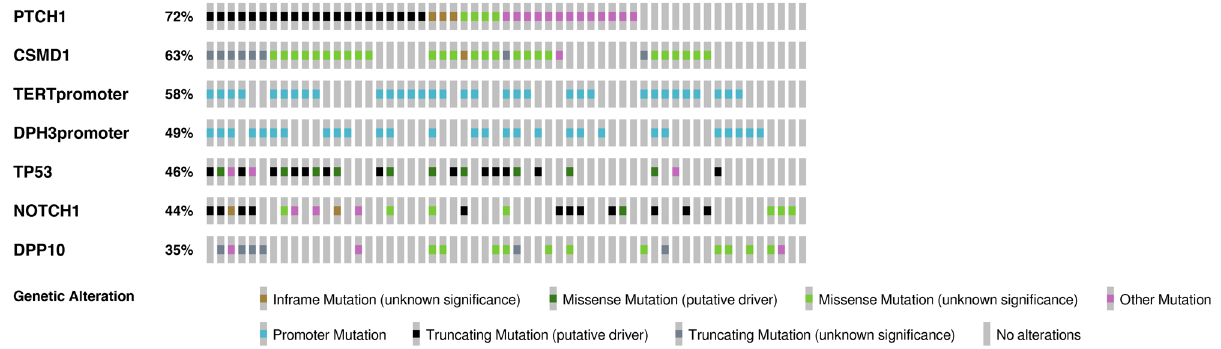
Figure 1. Distribution of somatic variants across the mutated genes. Each row represents a gene and each column corresponds to individual samples. When multiple mutations were present in a gene, only the pathogenetic or probable pathogenetic mutation was considered and shown in the diagram generated with Oncoprinter in cBioPortal